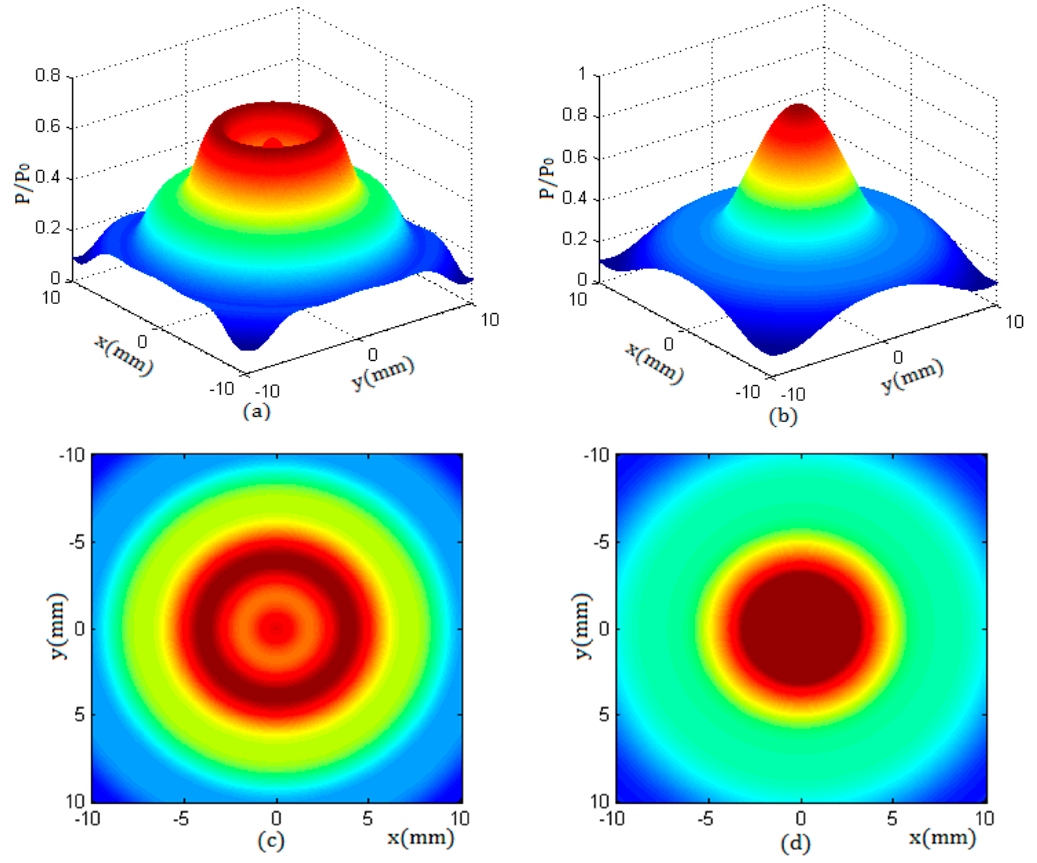
Figure 4. The sound pressure distribution of a round transducer with a radius of 10 mm in cross sections along the beam propagation direction; ( a , c ) the beam propagation distance z = 8 mm; ( b , d ) the beam propagation distance z = 20 mm.